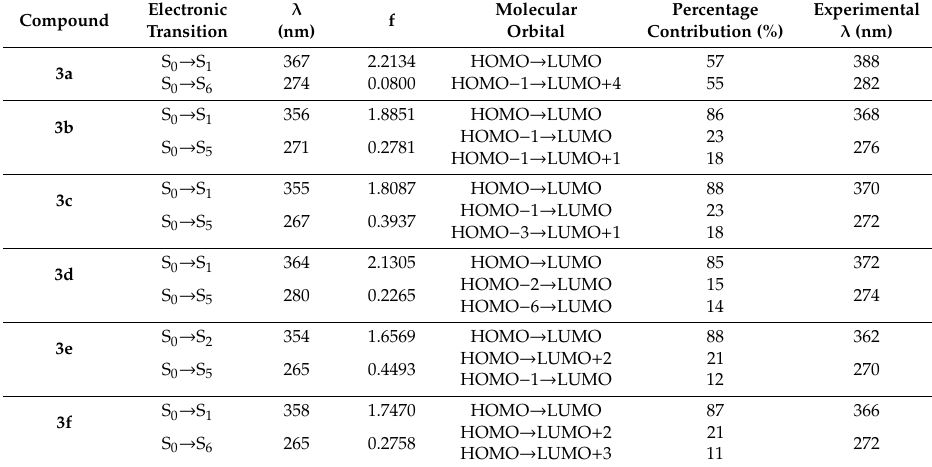
Table 6. The obtained values of the emission maxima correctly reflected the experimental data. Table 5. Electronic transition data obtained by TD–DFT // B3LYP // 6-311 + G (d), using a